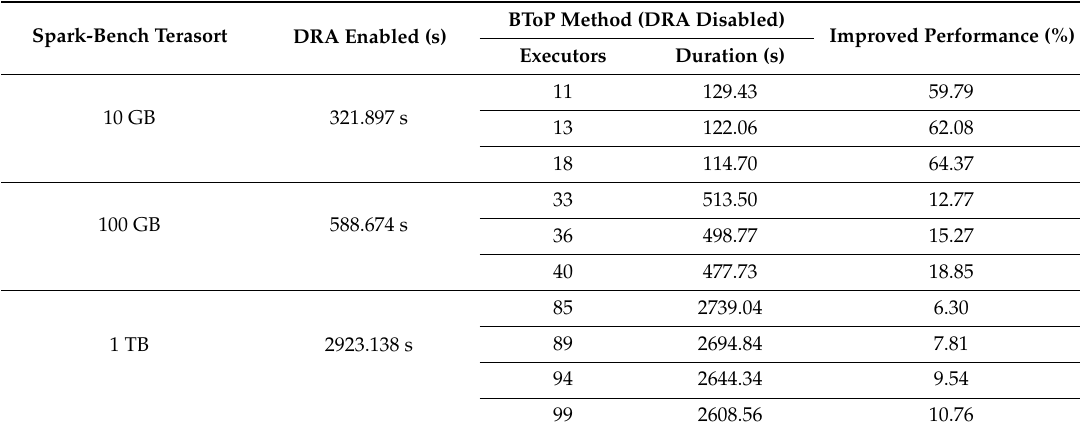
Table 1. Performance of Spark-Bench Terasort with Dynamic Resource Allocation (DRA) enabled vs. Spark using BToP method (with DRA